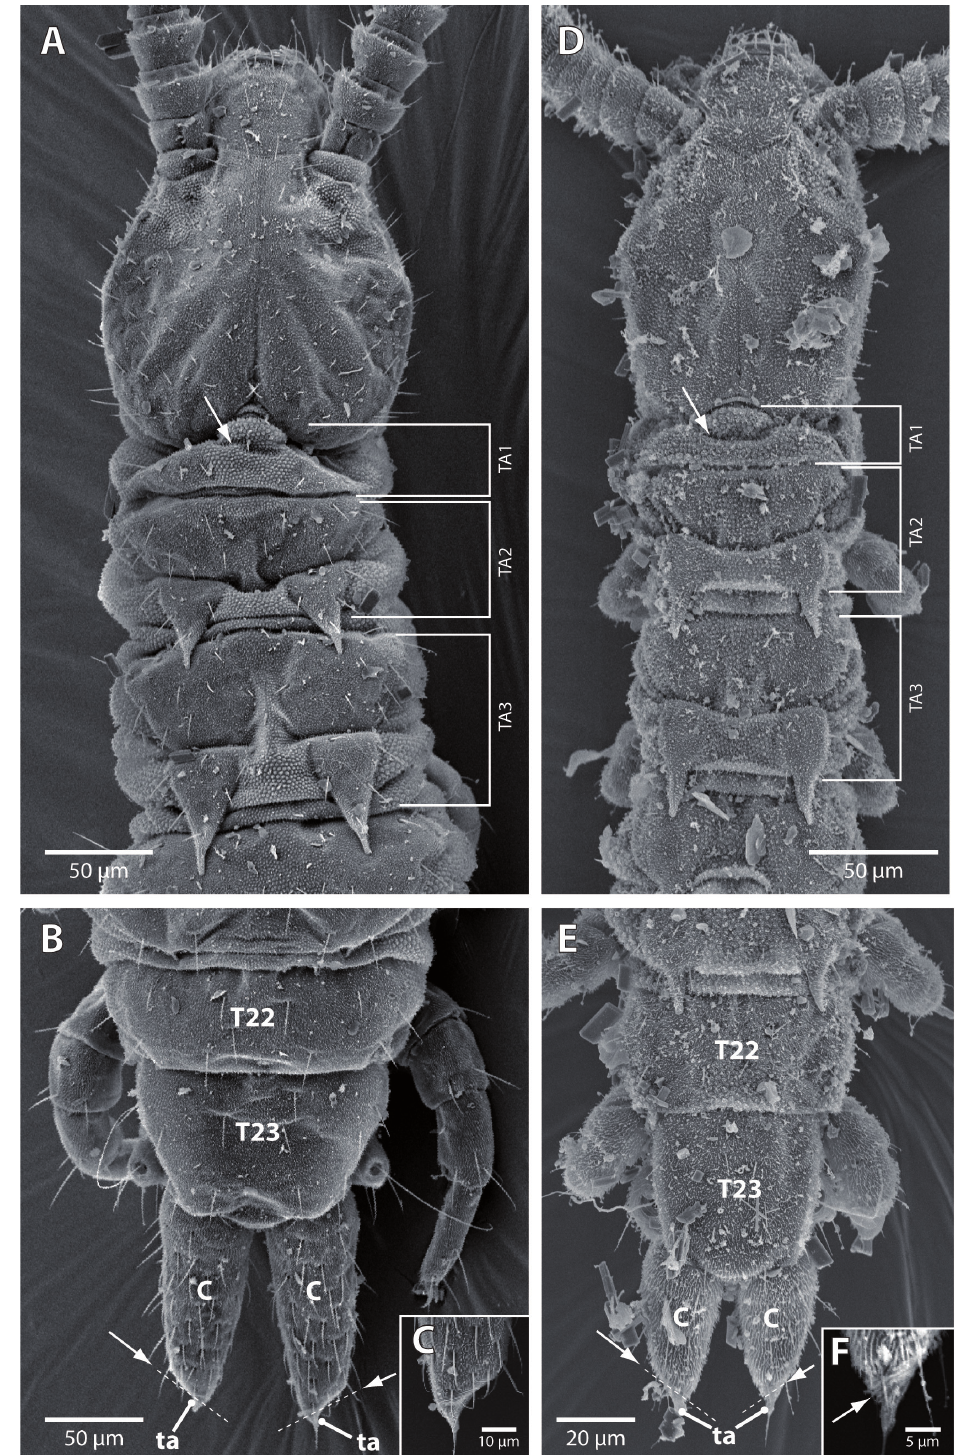
Fig. 11. — A-C . Ribautiella zagnanadina Brölemann, 1926. Museum material (MRAC 7832). — D-F . Ribautiella schoutedeni Hinschberger, 1954. Museum material (MRAC 6033). — A, D . Head and tergal areas 1-3 ( TA1-TA3 ) ( fide Domínguez Camacho 2009: 108, fig. 4 ). Arrows , fold in the first tergite – artefact. B, E . Penultimate ( T22 ) and last ( T23 ) tergites, and cerci ( C ). Arrow s, diagonal end of cerci – basis of the terminal areas ( ta ). C, F . Detail of the terminal area of the cerci. Arrow ,